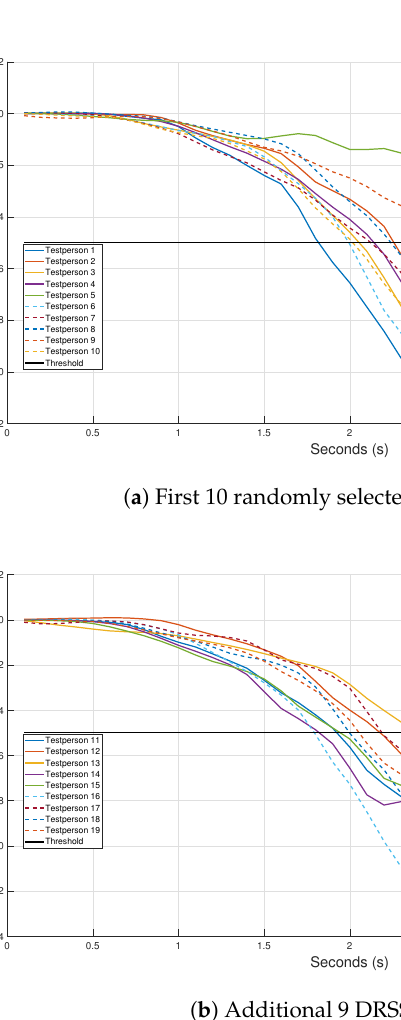
Figure 13. ∆ RSS lapse of 19 different people in a realistic office